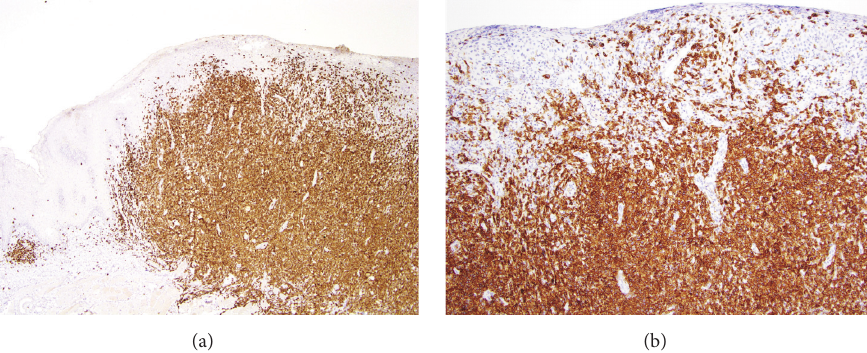
Figure 3: Immunohistochemistry shows that the large neoplastic cells are positive for CD3 (a) and CD30 (b). Immunohistochemistry with hematoxylin counterstain; × 40 (a) and × 100